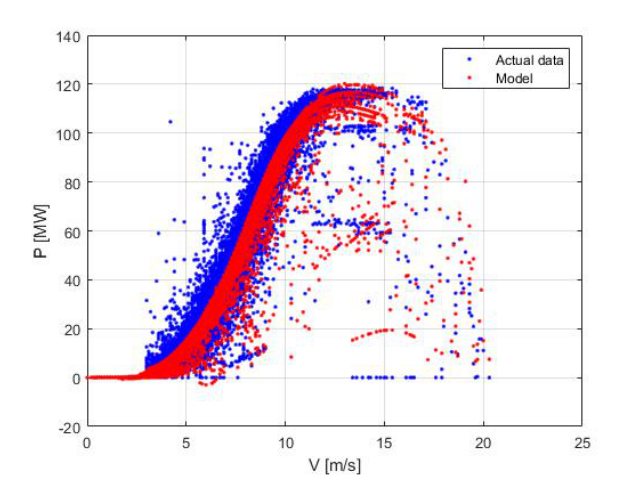
Figure 20. Data as measured and forecast of energy production from wind power plant FW2.